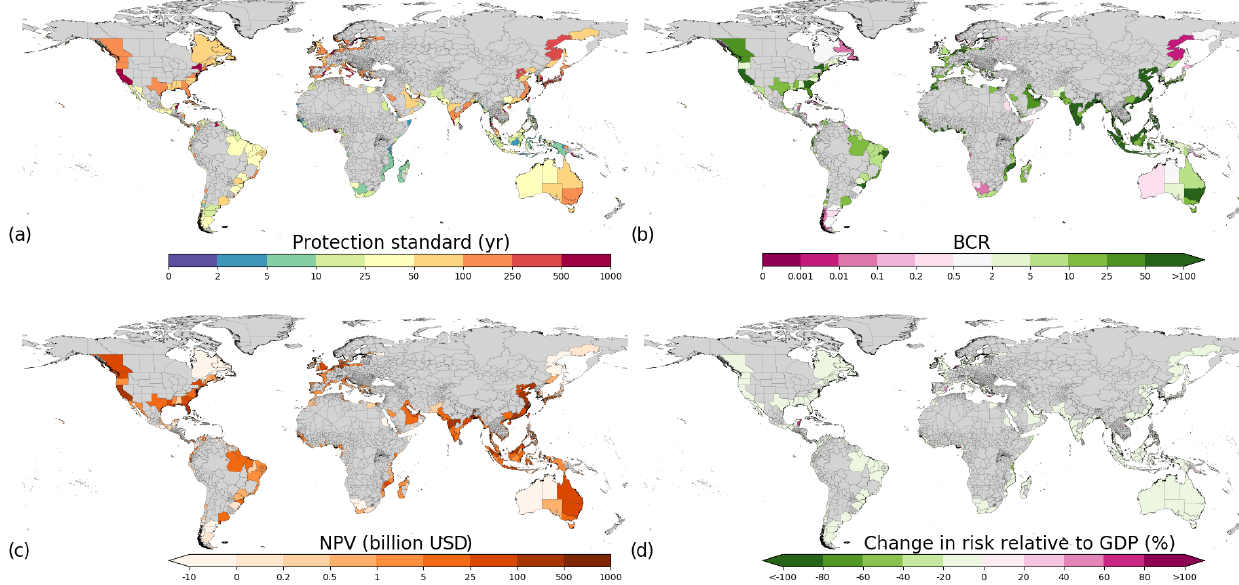
Figure 7. Relative-risk-constant adaptation objective results of (a) protection standards, (b) BCRs, (c) total NPV, and (d) change in risk relative to GDP for RCP4.5–SSP2. Regions with no data are indicated in grey.